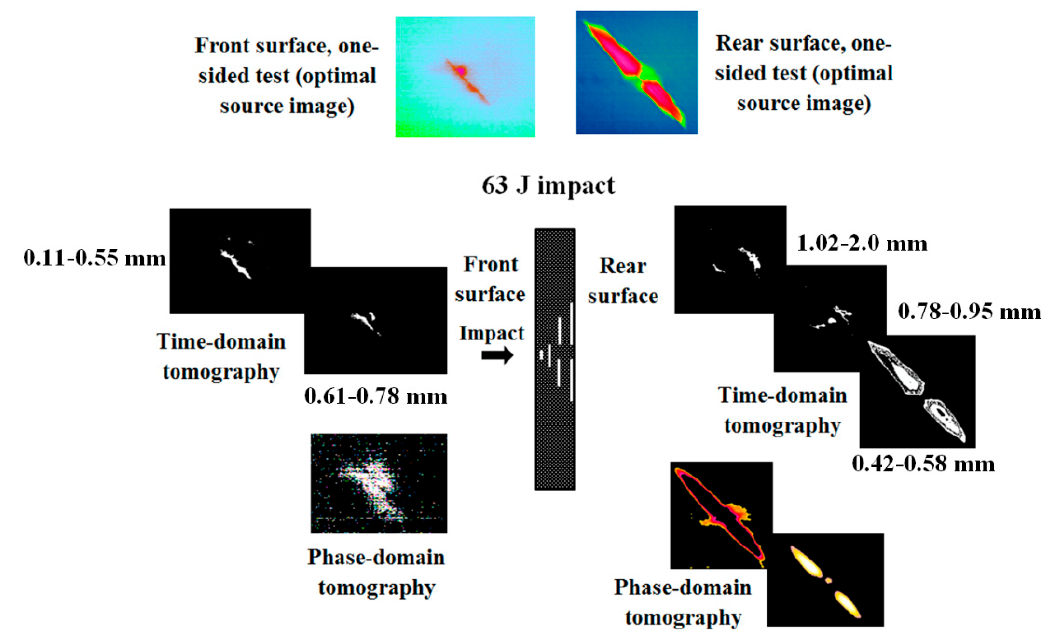
Figure 7. Time- and phase-domain thermal tomography of impact damage in 5 mm-thick CFRP sample (63 J impact energy).